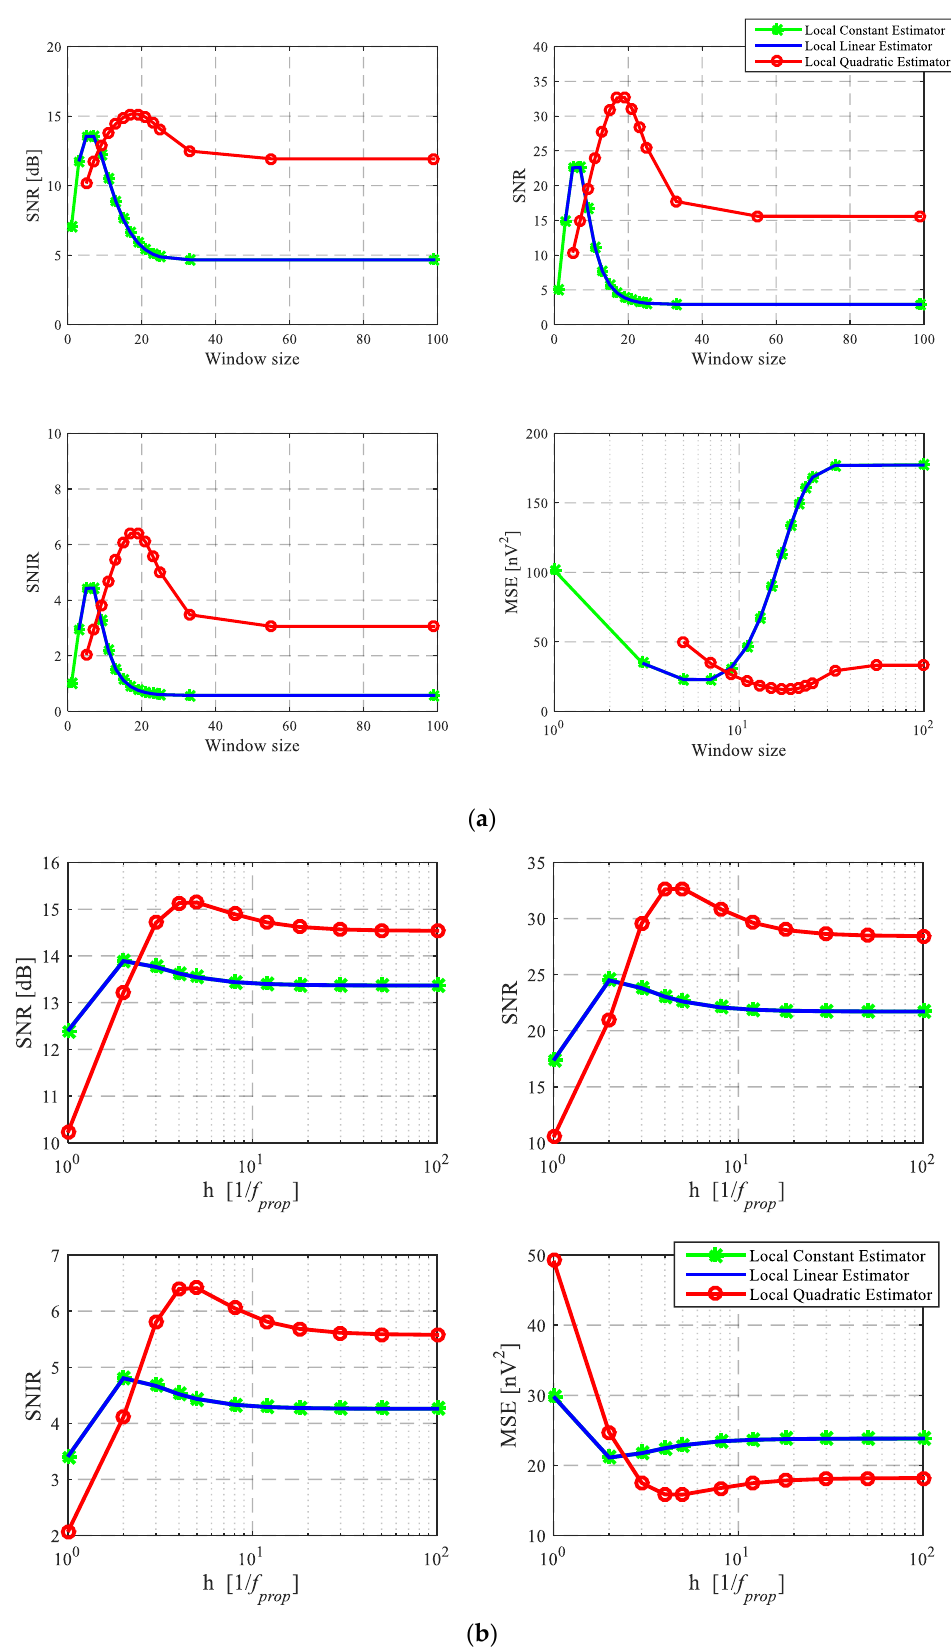
Figure 12. The effect of kernel regression parameters on estimation results. ( a ) The effect of window Figure 12. The e ff ect of kernel regression parameters on estimation results. ( a ) The e ff ect of window size. ( b ) The effect of the smoothing factor h. size. ( b ) The e ff ect of the smoothing factor